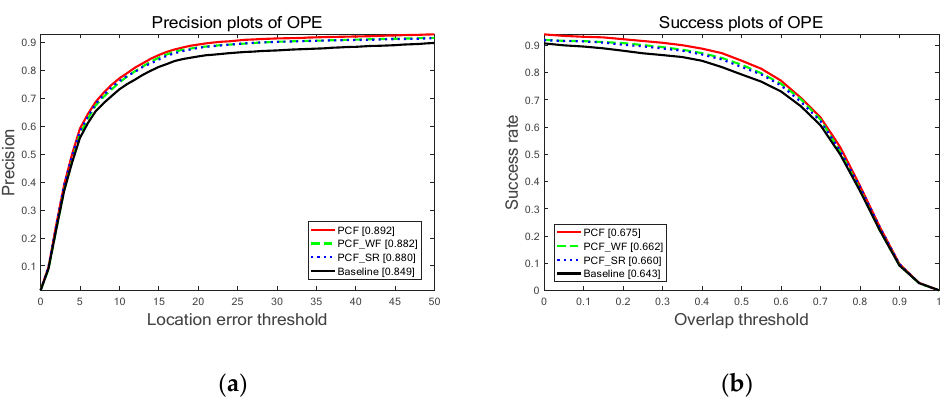
Figure 6. The results of the ablation experiments on OTB-2013 benchmark for the baseline tracker, the proposed PCF tracker and the trackers of progressively integrating the presented strategies: ( a ) The precision plots (PP) of one pass evaluation (OPE) and the values in brackets denote the OPE accuracy of location error threshold (LET) at 20 pixels; ( b ) The success plots (SP) of the OPE and the numbers in brackets are the areas under the curve (AUC).